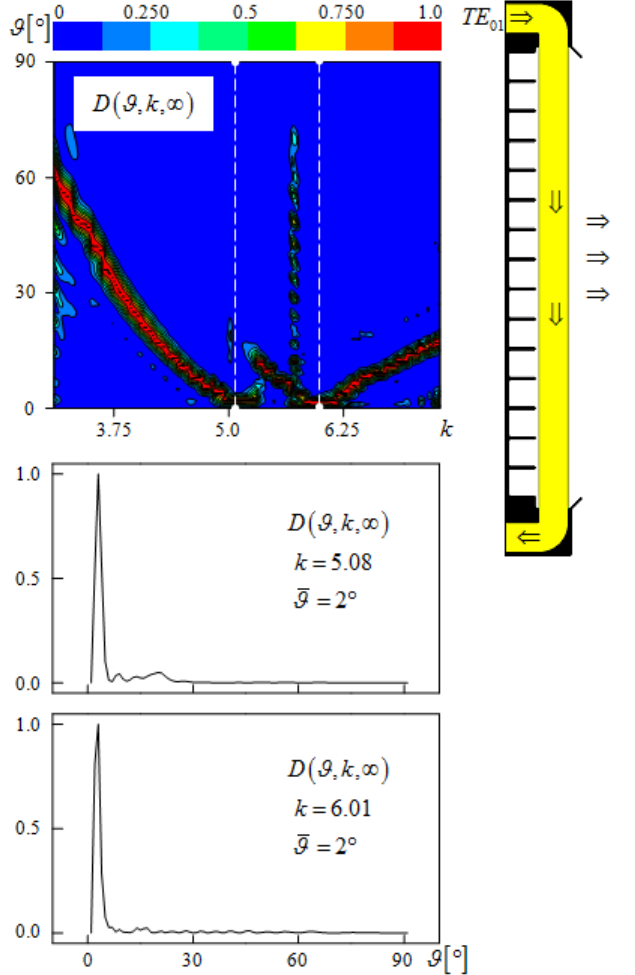
∞ ) in the frequency band